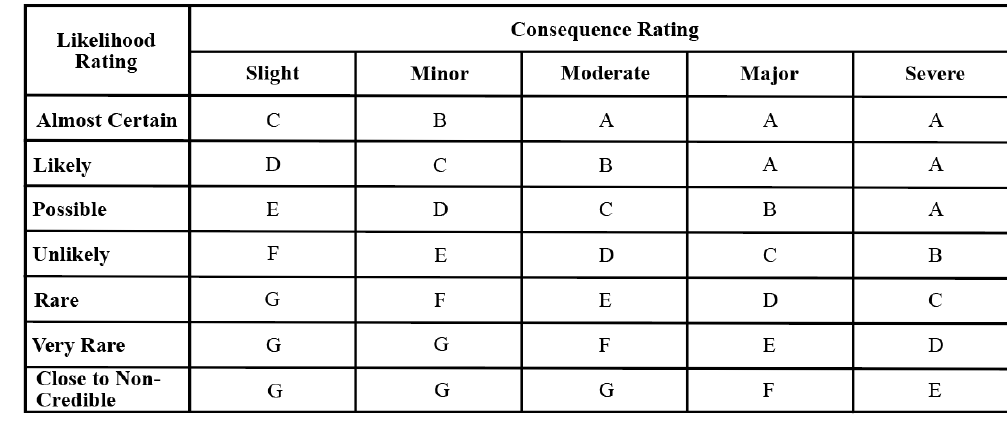
Figure A3. Risk matrix based on Levine [29].